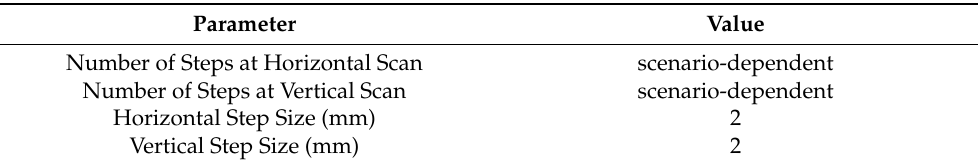
Table 3. Rail parameters. Parameter Number of Steps at Horizontal